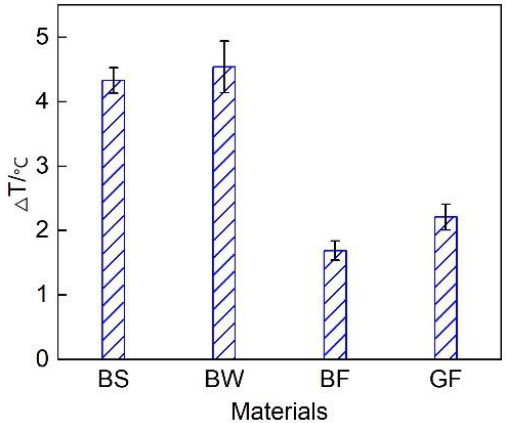
Figure 6. Average temperature decrease in the exhaust pipes with different covering schemes.